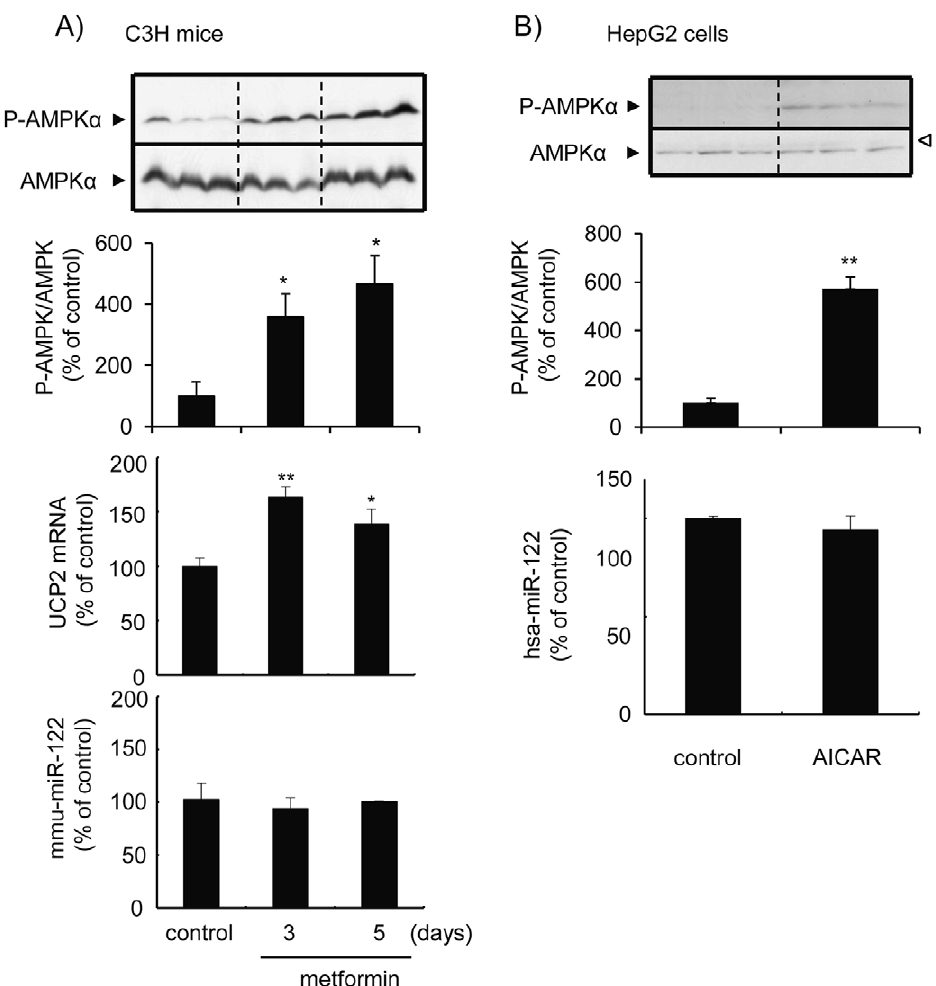
Figure 3. AMPK activation does not cause a miR-122 down-regulation. A , Mice were treated with metformin (250 mg/kg, ip. ) twice a day at a 12 h-interval for 3 days or 5 days and were sacrificed 12 h after the final treatment. Activated and total AMPK levels in the liver of mice were determined by Western blot analysis using anti-phospho-AMPK a (Thr 172) and AMPK a specific antibodies, respectively (the top panel). Levels of phospho-AMPK a was normalized with respective AMPK a and are illustrated as the % of control group (the second panel). UCP2 mRNA (the third panel) and miR-122 (the last panel) levels were determined by the quantitative RT-PCR, were normalized with b -actin and the U6 snRNA, respectively, and are illustrated as the % of control group. *, p , 0.05; **, p , 0.01. B , HepG2 cells were treated with AICAR (1 mM) for 24 h. Activated and total AMPK levels were measured by Western blot analysis using phospho-AMPK a (Thr 172) and AMPK a specific antibodies, respectively (the top panel). The open arrow head illustrated on the right indicates a nonspecific band. Levels of phospho-AMPK a was normalized with respective AMPK a and are illustrated as the % of control group (the middle panel). MiR-122 levels were determined by the quantitative RT-PCR, were normalized with the respective U6 snRNA and are illustrated as the % of control group (the last